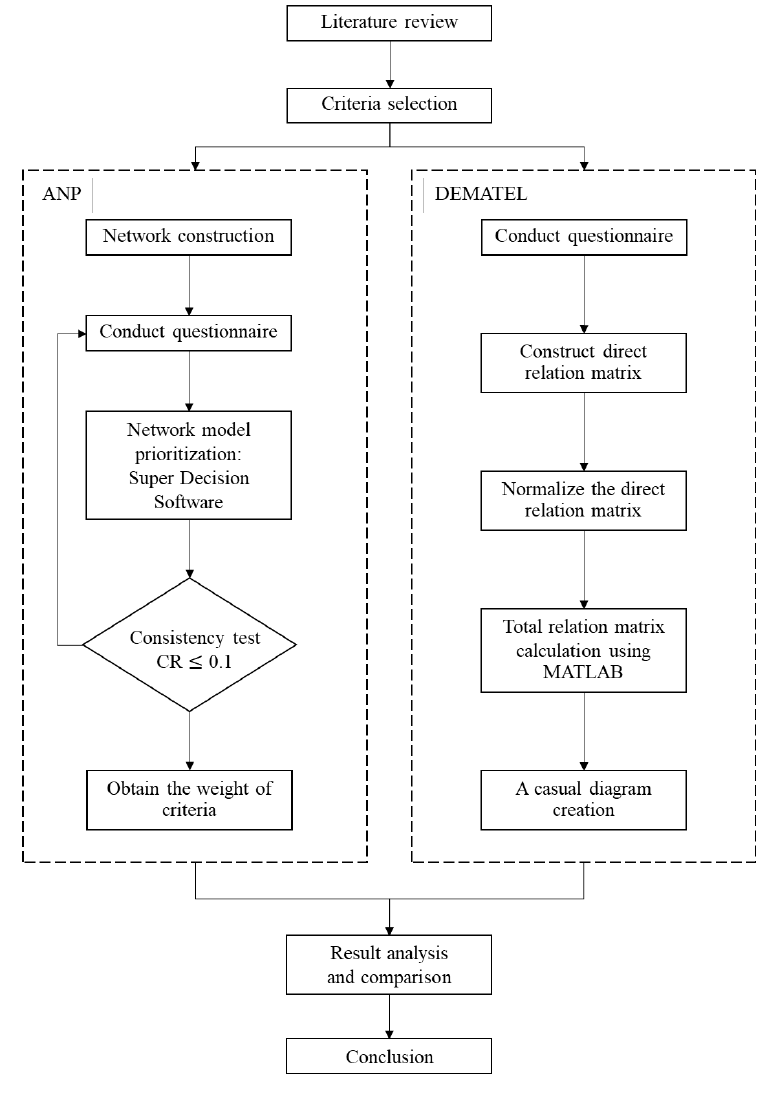
Figure 1. Research flowchart. Table 2. Barriers of EV